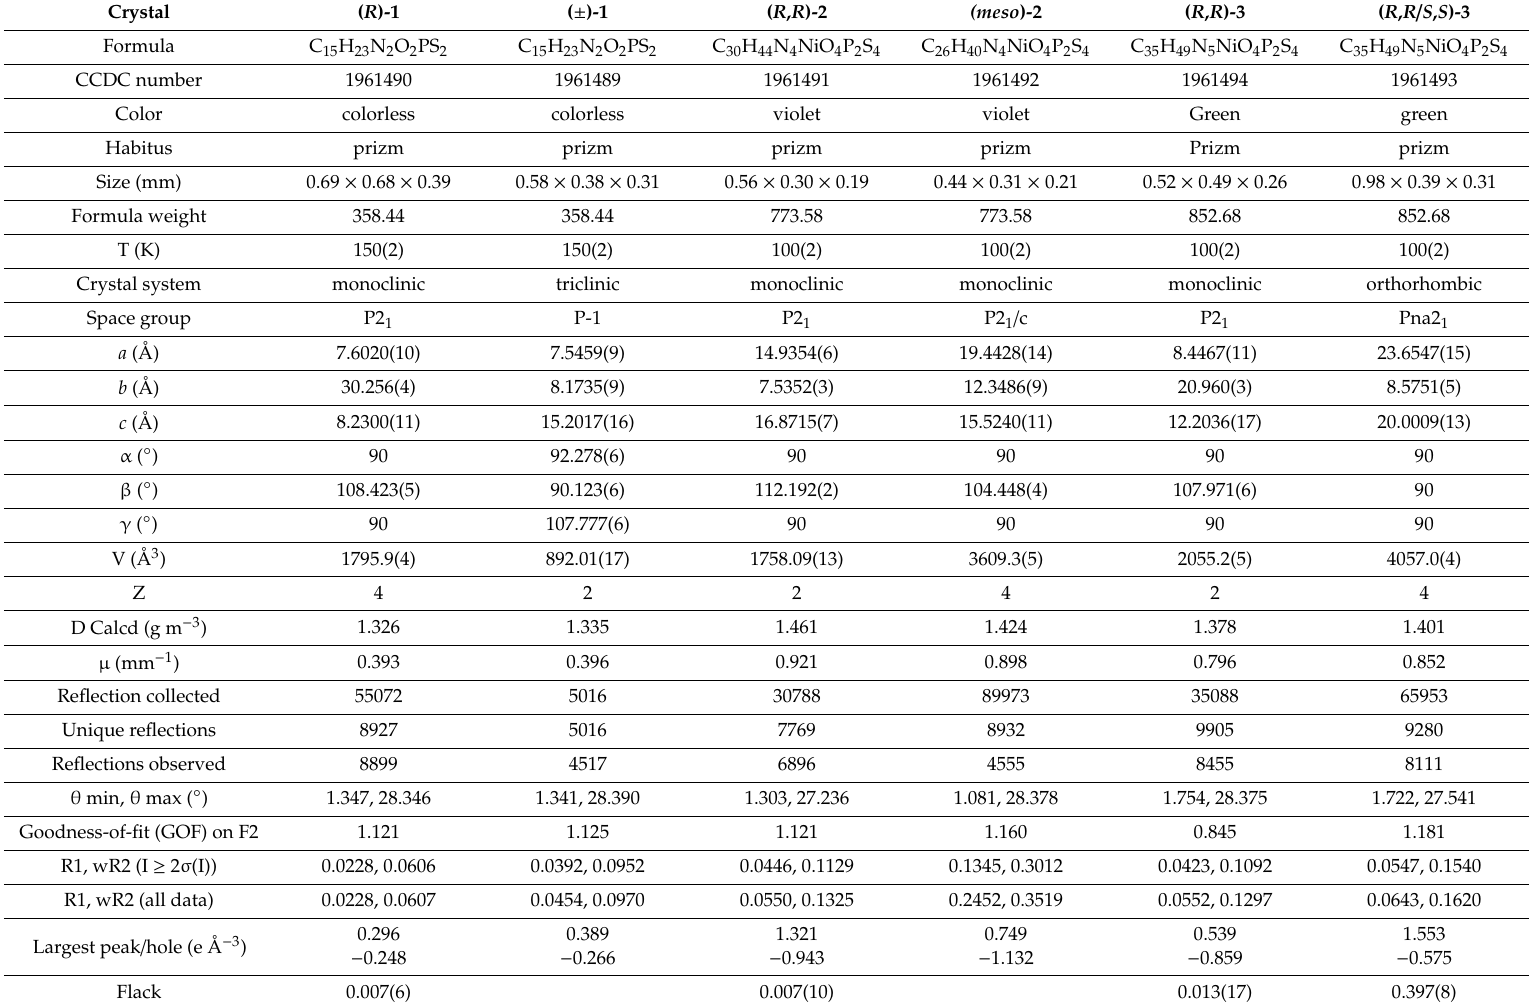
Table 1. Crystallographic data and structure refinement details for compounds 1 – 3